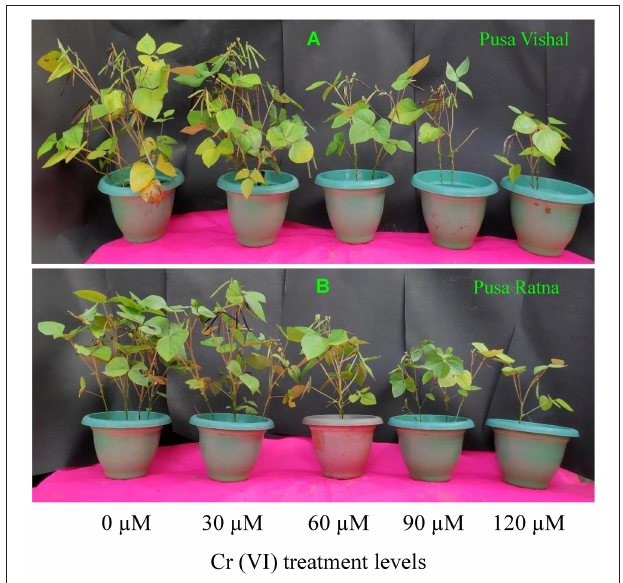
FIGURE 6 | Effect of different chromium (Cr [IV]) treatments on growth, yield and yield-components of two Mungbean cultivars, (A) Pusa Vishal (PV) and (B) Pusa Ratna (PR).